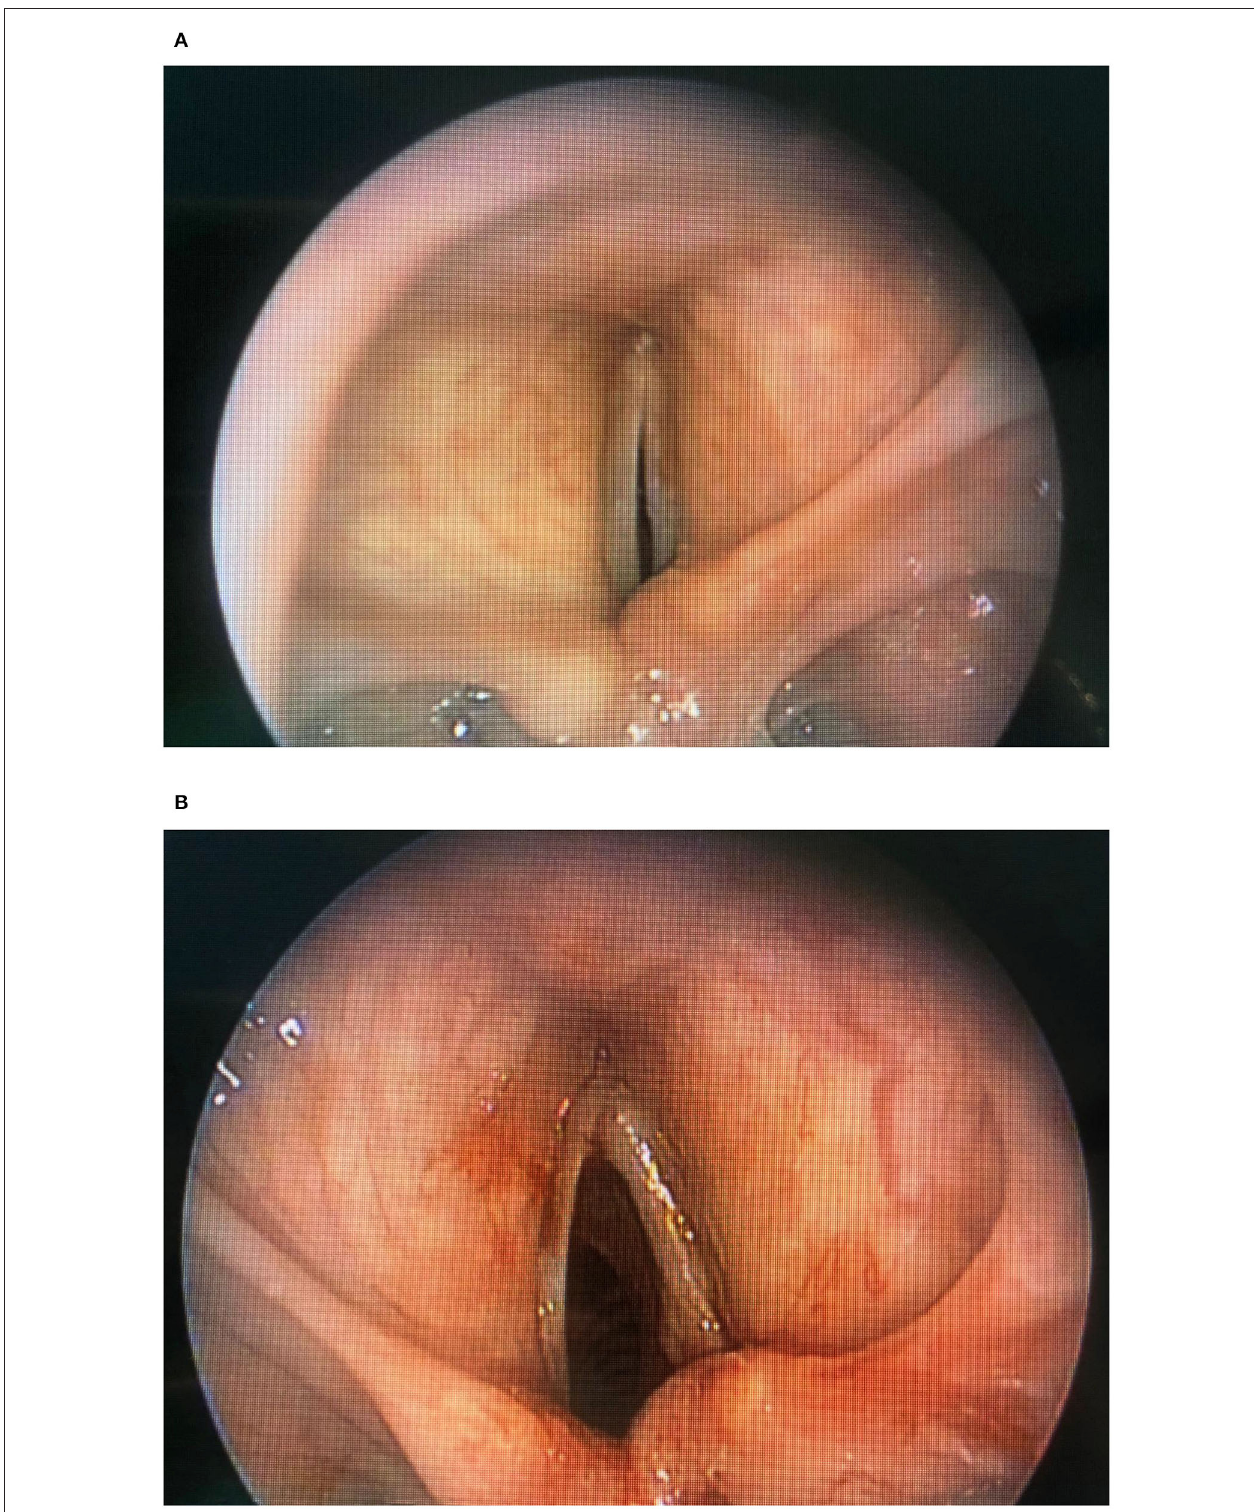
FIGURE 4 | (A) Endoscopic arytenoid lateropexy (before surgery). (B) Endoscopic arytenoid lateropexy (after surgery).